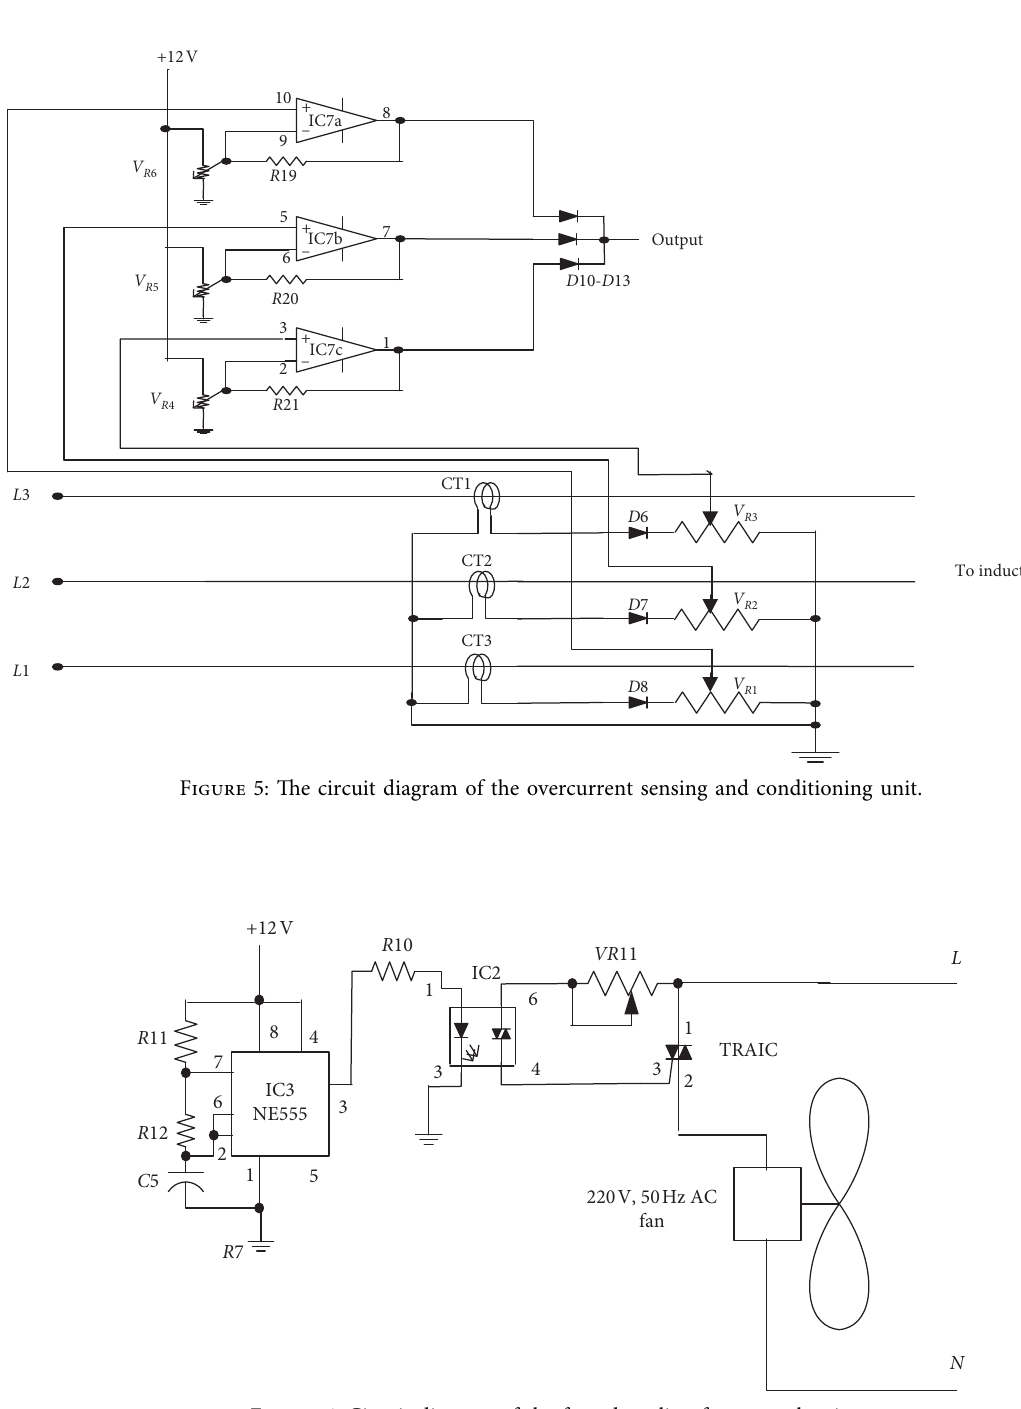
Figure 6: Circuit diagram of the forced cooling fan control unit.